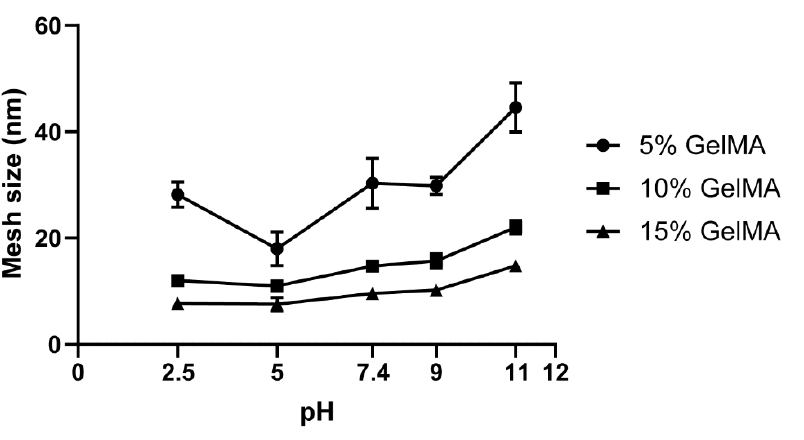
Figure 8. Mesh size for GelMA hydrogels (5% to 15%) crosslinked in water and swelled at differ- ent pH.